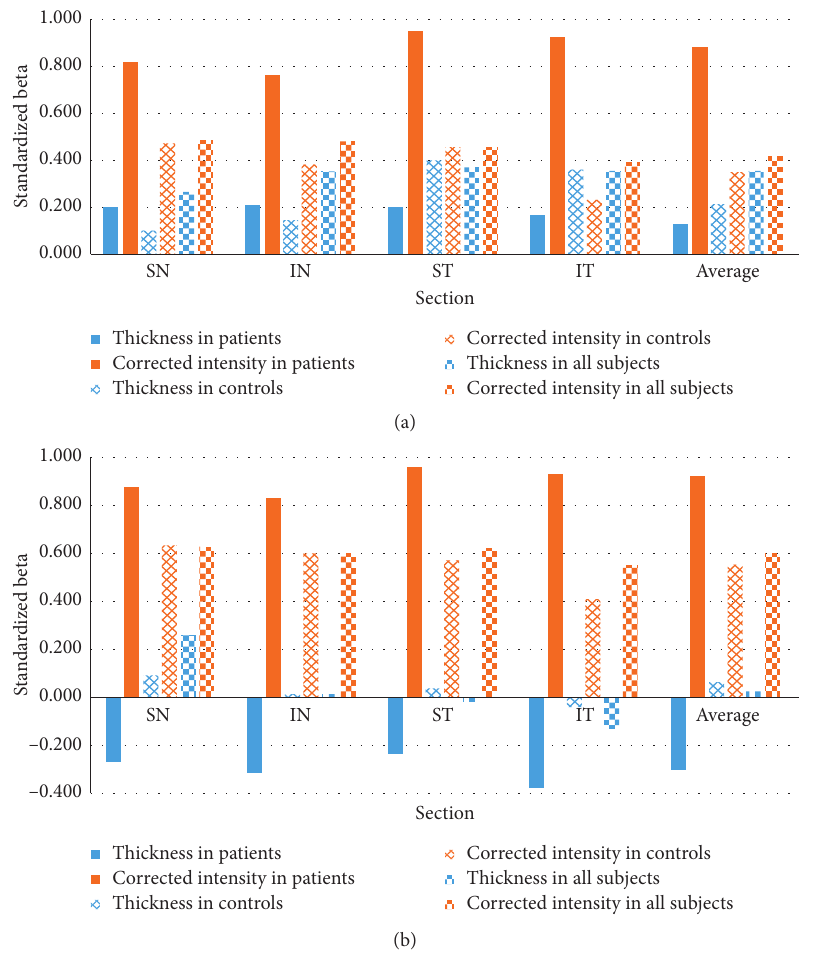
Figure 3: Correlations between attenuation coefficient and thickness and the corrected intensity in RNFL (a) and in GCIPL (b) for patients, controls, and all subjects,